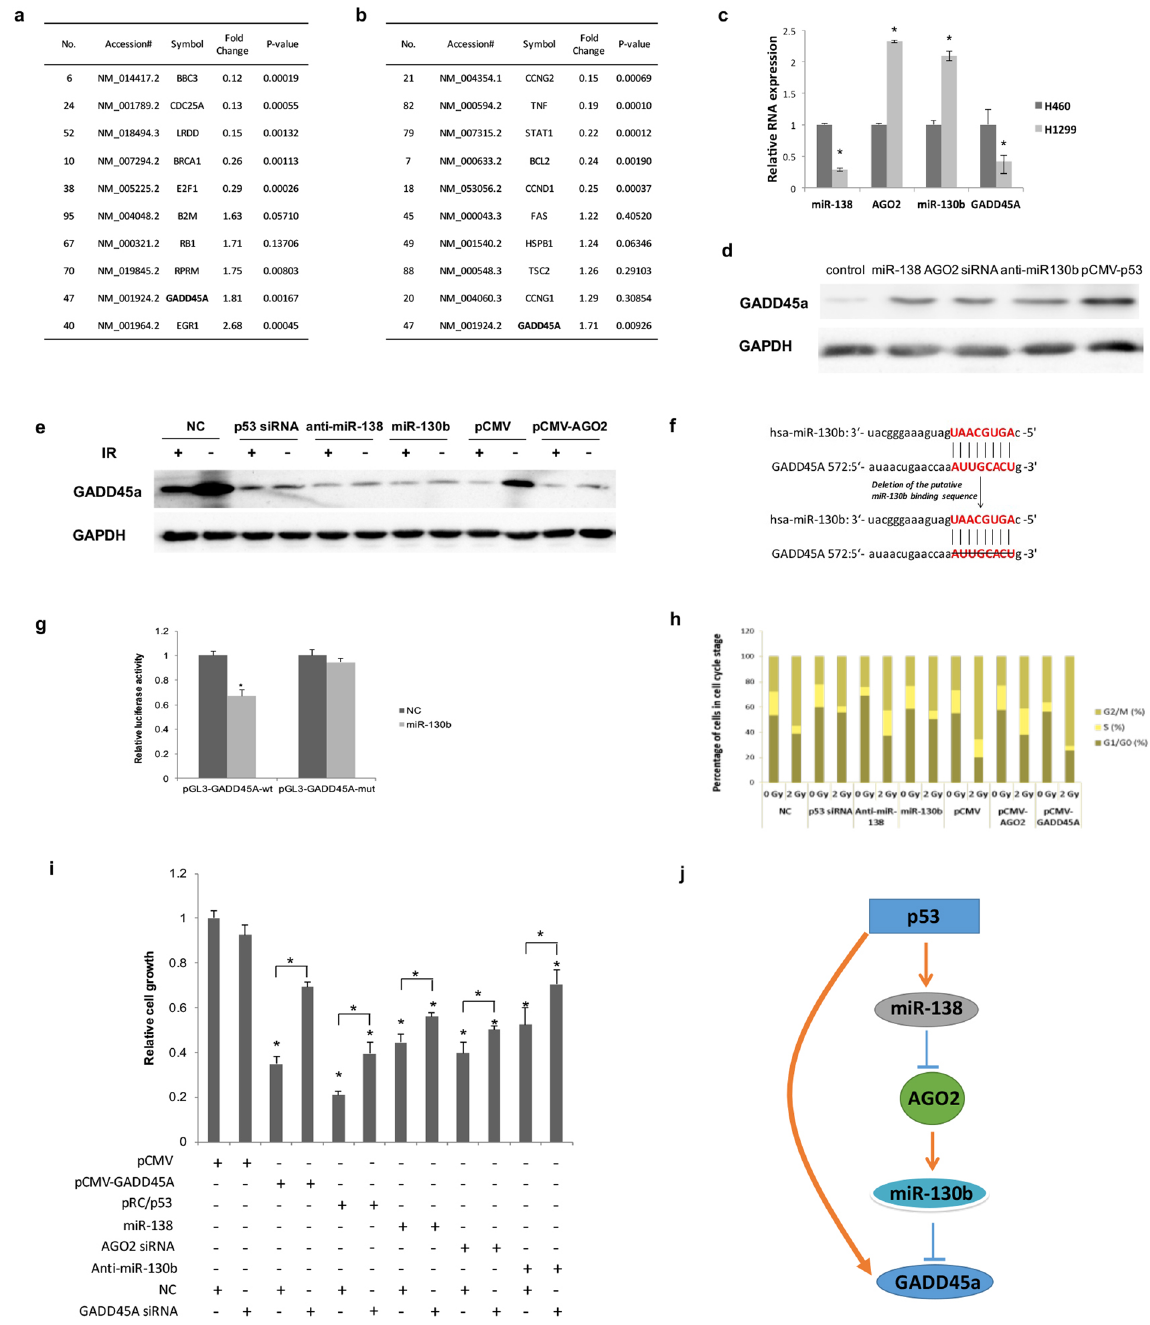
Figure 4. p53-miR-138-AGO2-miR-130b pathway regulation of GADD45A in human NSCLC cells. Human p53 signalling pathway PCR array analysis. p53 signalling pathway gene expression profiles in H1299 cells treated with AGO2 siRNA, miR-138, or negative control were analyzed using a q-PCR array ( a , b ). a Only the top ten most significantly changed genes are listed (for more details, see GEO: GSE69561). ( c ) The relative expression levels of GADD45A mRNA, AGO2 mRNA, miR-130b and miR-138 were quantified in H460 and H1299 cells using real-time PCR. GAPDH mRNA and U6 snRNA served as internal controls, separately. * P < 0.05 by rank-sum test. ( d ) GADD45A protein was analyzed with western blotting in H1299 cells transfected with miR-138, AGO2 siRNA, negative control or p53 expression plasmid. Full-length blots are in Supplementary information. ( e ) H460 cells were transfected with p53 siRNA, anti-miR-138, miR-130b, pCMV- AGO2, or control plasmid. GADD45A protein was analyzed with western blotting when cells were treated with or without 2 Gy of IR, and then cultured for 8 hours. Full-length blots are in Supplementary information. ( f ) Schematic representation of the miR-130b target in the 3 ′ UTR of human GADD45A (top). The positions of the miR-138 binding sites correspond to the location of the GenBank accession number NM_001199742. The mutant 3 ′ UTR without the miR-130b binding sites is shown in the bottom image. ( g ) Dual-luciferase reporter assays were performed to test the interaction between miR-130b and the predicted wild-type GADD45A 3